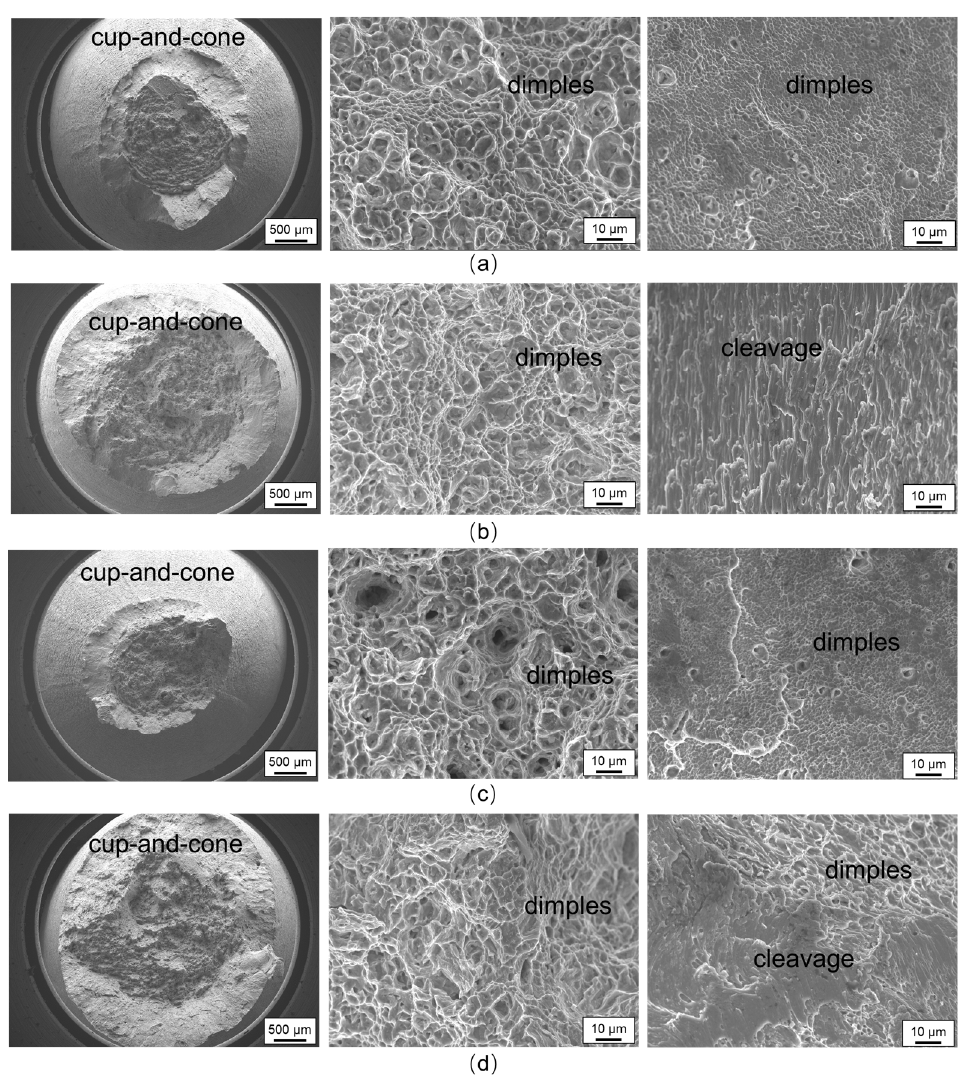
Figure 6. Fracture surfaces of the samples tested at room temperature: ( a ) annealed, ( b ) ST, ( c ) STA1, and ( d ) STA2.